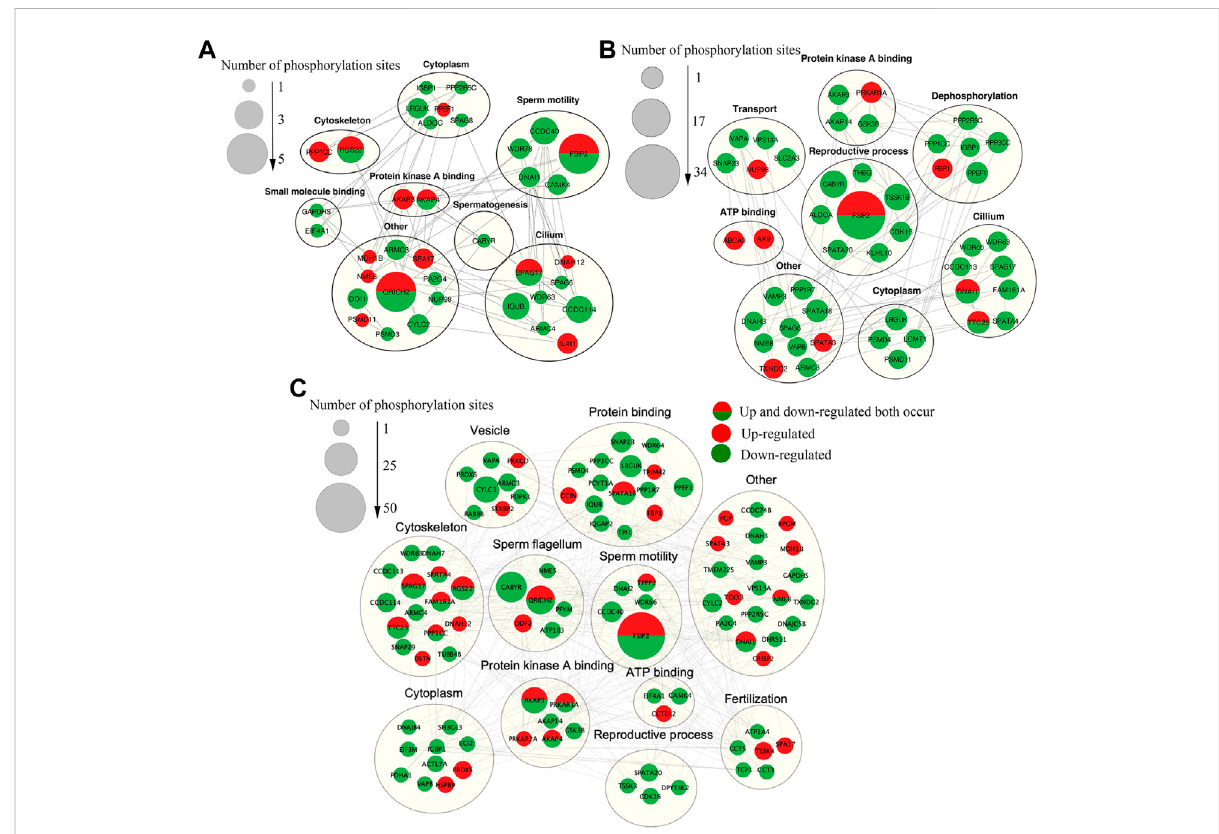
The Interaction network of phosphorylated proteins. (A) The PPI network of DEPPs between CAP and FTH sperm. (B) The PPI network of DEPPs between AR and CAP sperm. (C) The PPI network of DEPPs betweenAR and FTH sperm. In the constructed network, thenumber of phosphorylation sites are represented as nodes. While interactions among proteins are represented as edges for proteins with > 2 connections. Signi fi cantly upregulated and downregulated phosphorylation sites are indicated in red and green, respectively. Red (half) and green (half) showed that upregulated and downregulated phosphorylation sites both occurred. Identi fi ed phosphorylated proteins were grouped based on known biological